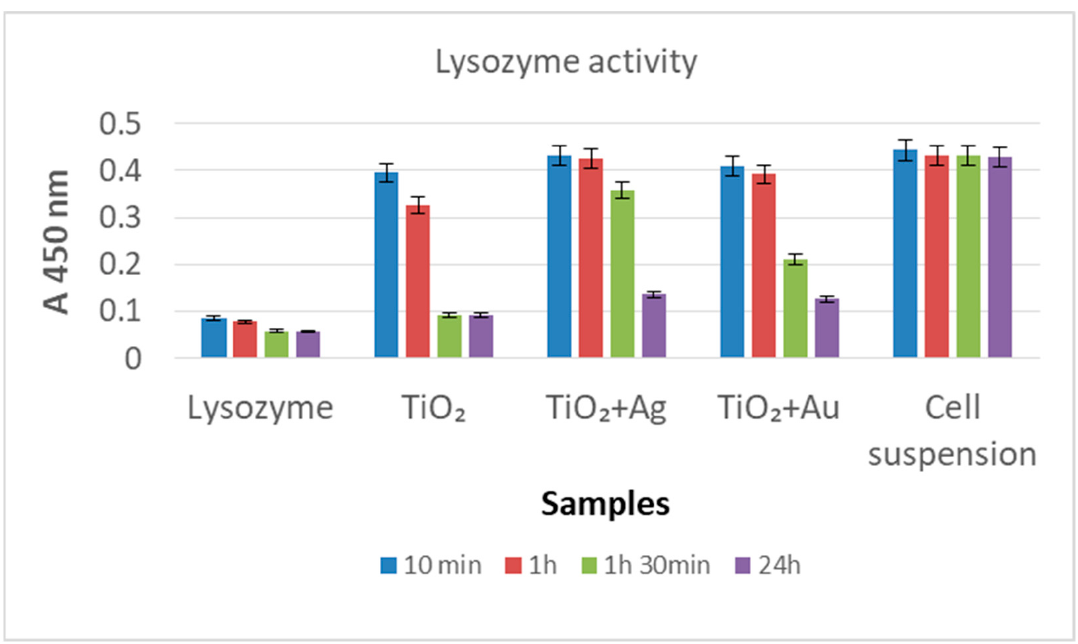
Figure 9. Activity of lysozyme (free and loaded on inorganic coatings) against M. lysodeicticus .